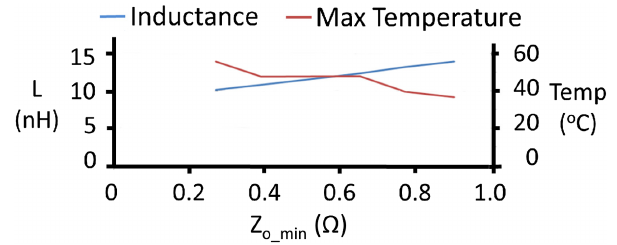
FIG. 4. The CSMITL inductance between the vacuum insulator and the disk feed at r ¼ 8 cm and the maximum anode temper- ature (from an initial anode temperature of 21 °C) are shown as a function of Z o min